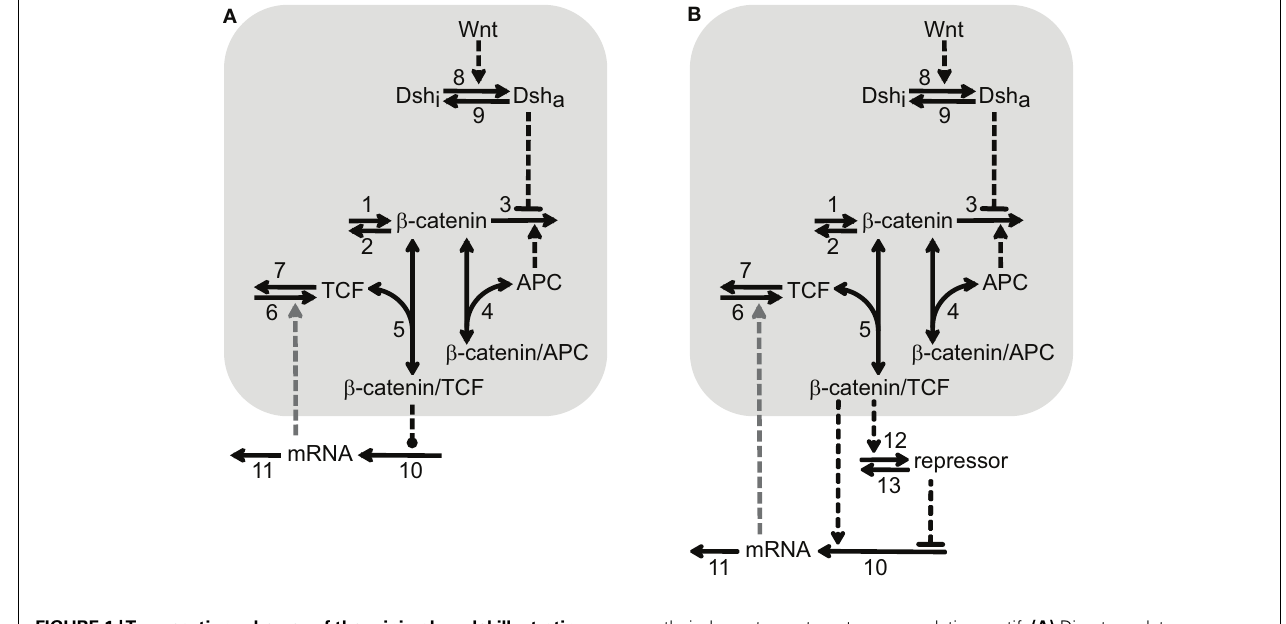
FIGURE 1 |Two reaction schemes of the minimal model illustrating different mechanisms ofWnt/ β -catenin target gene regulation. The signal transduction module is shared by (A,B) and highlighted by a light gray background. It consists of the reactions 1–9 that are explained in the text.The number next to the arrow denotes the particular reaction. One-headed arrows denote reactions taking place in the indicated direction. Double-headed arrows illustrate binding reactions. Dashed arrows represent activation steps and inverted, dashed “T”s denote inhibition.The gray, dashed arrow connecting the mRNA and reaction 6 indicates the possible feedback considered in Section “Transcriptional feedback regulation viaTCF family members”.The two schemes differ in